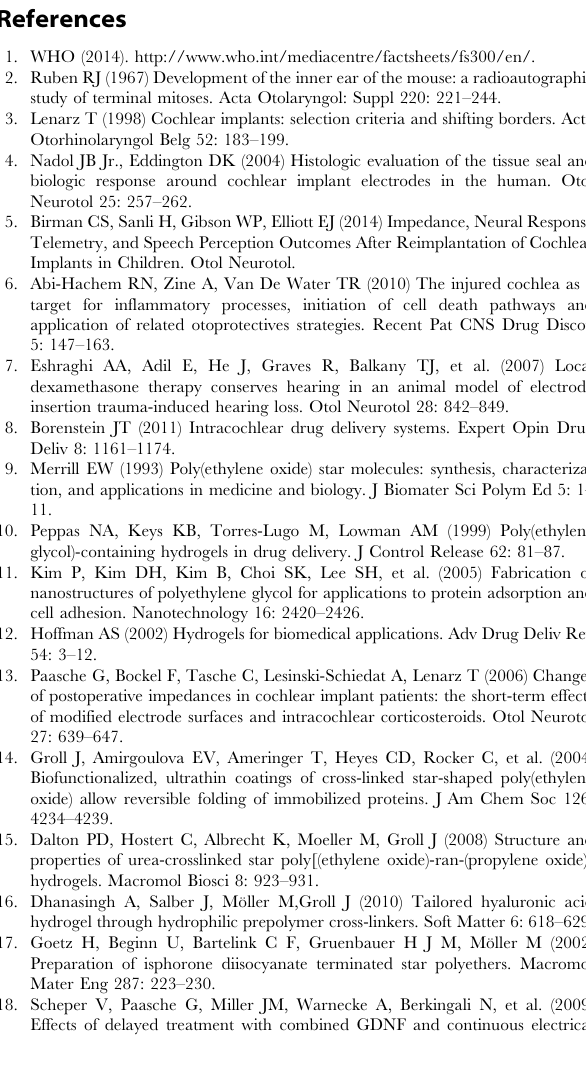
Figure S7 Frequency specific hearing loss. The mean and SD of hearing loss of all experimental groups after 28 days of implantation is plotted for each frequency tested. In all groups the hearing loss seems to be less affected in the lower frequencies but statistical evaluation did not show any significant differences between the frequency specific hearing loss in any of the experimental groups. Figure S8 Tissue growth evaluated by ranking. The mean 6 SEM results of subjective ranking of tissue formation in the cochlea turns of each experimental group are plotted. In all groups the tissue reaction is significantly increased in the basal regions compared to the middle and apical regions. Fibrotic tissue response in more apical turns was only detected in the trauma group (A) and did not take place in reservoir groups treated with PBS (B) or DEX (C). One-way ANOVA in combination with the Tukey post-test was used to compare the tissue growth within the different cochlea turns of each experimental group: **=p , 0.01; *** = p , 0.001. Reference of the significance is marked by the thick bar. Figure S9 Tissue growth evaluated by measurement. The mean 6 SEM percentage of scala tympani area of